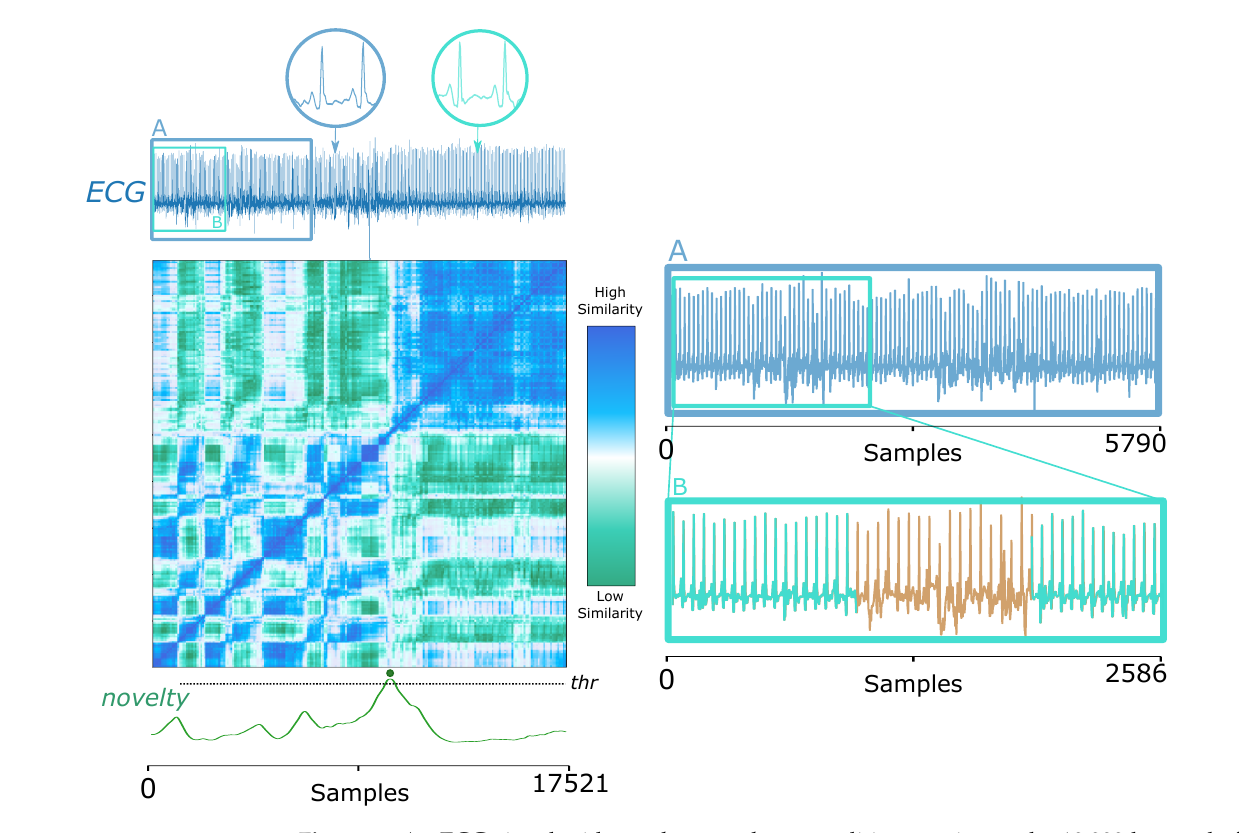
Figure 8. An ECG signal with a pulsus paradoxus condition starting at the 10,000th sample from Dataset 7 (ECG Pulsus Paradoxus, see Section 3.7). ( Left ): the SSM diagnoses two modes in the signal, whose patterns are zoomed in the circle thumbnails, respectively; ( right ): zooming parts of the original signal can verify SSM’s ability of automatic ECG pattern change detection and contribution to segmentation. The novelty function is presented, and the peak is aligned with the ground truth event, represented as a